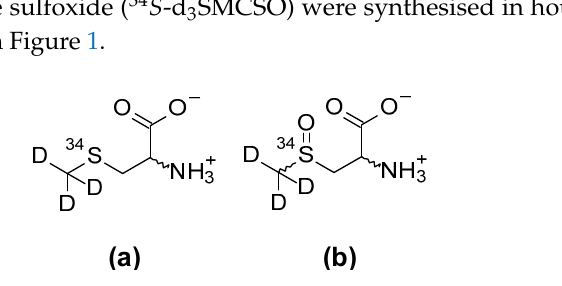
Figure 1. Structures of internal standards ( a ) 34 S -Trideuteromethylcysteine ( 34 S -d 3 SMC) and ( b ) 34 S -trideuteromethylcysteine sulfoxide ( 34 S -d 3 SMCSO). 2.1.1. Identification of 34 S -Trideuteromethylcysteine by 1H-NMR / δ (D 2 O) and Mass Spectroscopy 3.94, dd, J = 4.2, 7.8 Hz, 1H, H- α ; 3.10, dd, J = 4.2, 14.9 Hz, 1H, H- β ; 3.00, dd, J = 7.8, 14.9 Hz,